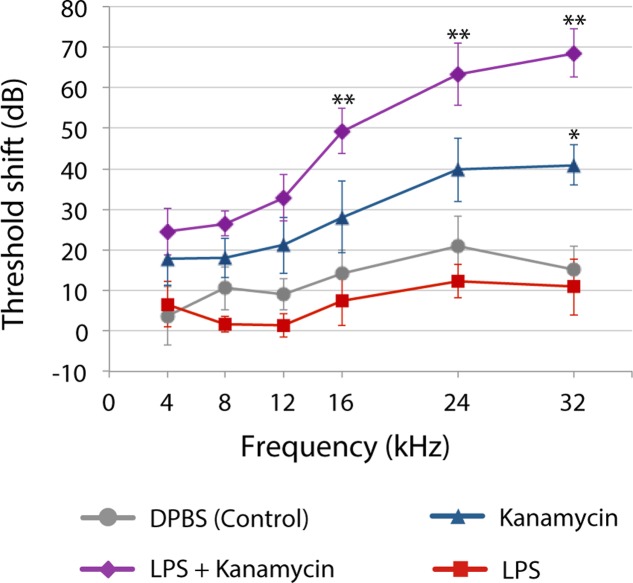
Three weeks after chronic [lipopolysaccharides (LPS) or saline] exposure with or without twice daily kanamycin dosing, ABR threshold shifts for mice treated with LPS-only (red) were not different from saline-treated mice (DPBS, gray). Kanamycin alone (700 mg/kg, twice daily; blue) induced a small but significant PTS at only 32 kHz (∗P < 0.01) compared to saline-treated mice (gray). that received LPS plus kanamycin (purple) had significant PTS at 16, 24 (∗∗P < 0.01), and 32 kHz (P < 0.05) compared to mice treated with kanamycin, saline or LPS only (∗∗P < 0.01). Mice receiving LPS plus kanamycin also had significant PTS at 12 kHz compared to mice treated with DPBS or LPS only, or LPS-only mice at 8 kHz. Error bars = SD. Figure adapted from Koo et al., 2015, with permission from Science/American Association for the Advancement of Science.